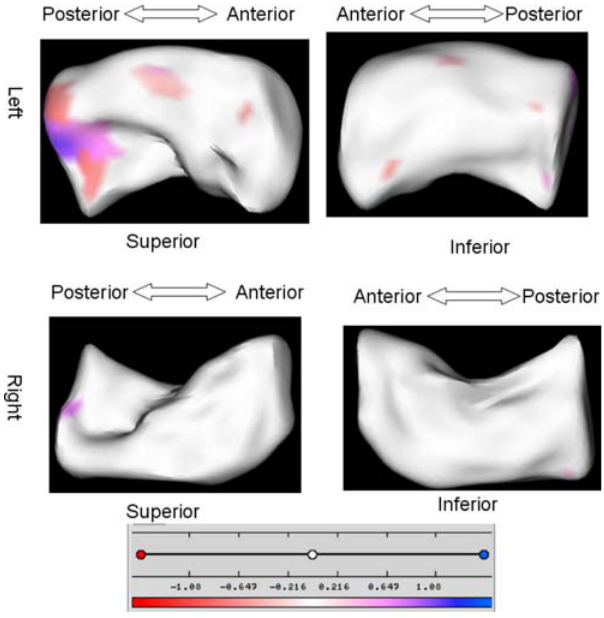
Figure 3. A pair of representative hippocampi are along with the T1 MRI scan from which the hippocampi were segmented.